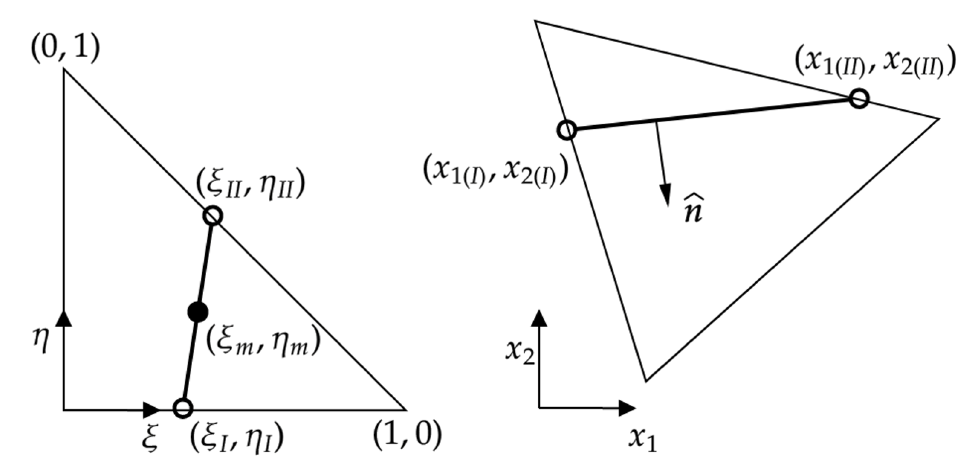
Figure 5. Element T e (right) described in the Cartesian coordinate system ( x 1 , x 2 ) is mapped into reference element (left) described by ( ξ , η ) coordinates. Outward normal ˆ n to the portion of Γ N (respectively, Γ R ) in T e is to be determined in the Cartesian framework. The two points where the interface meets the boundary of T e (entry and exit points, here denoted by I and II ) are necessary to numerically integrate the coefficients of F (respectively M ) along Γ N (respectively, Γ R ).